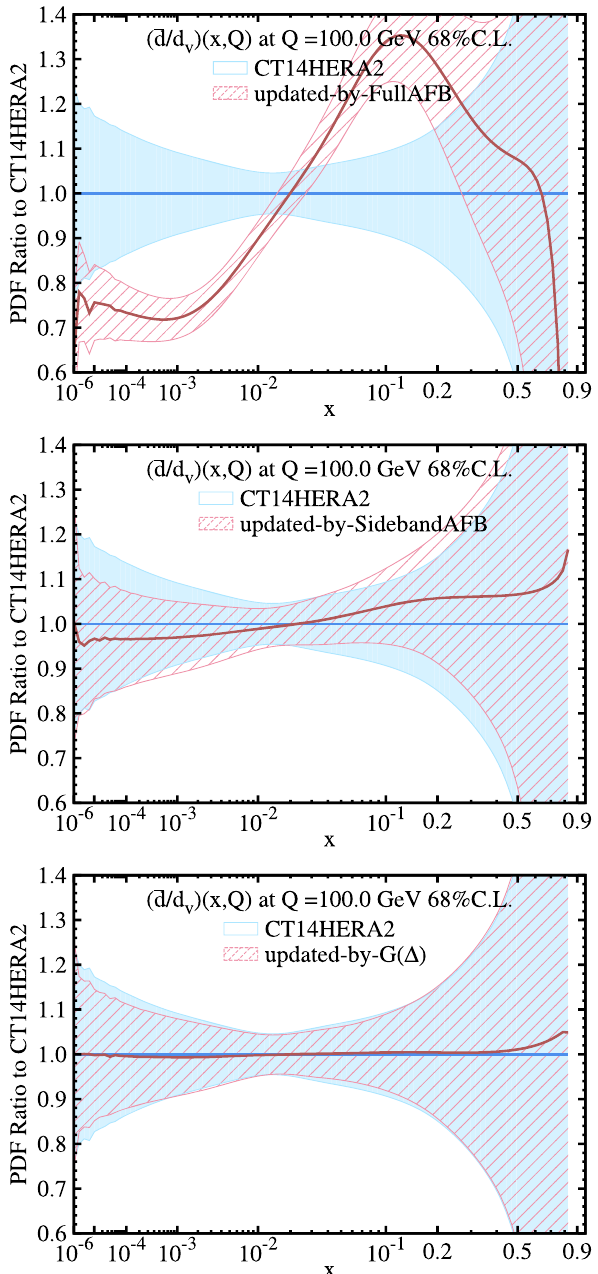
Fig. 6 Similar to Fig. 5, but for the PDF ratio ¯ d / d valence